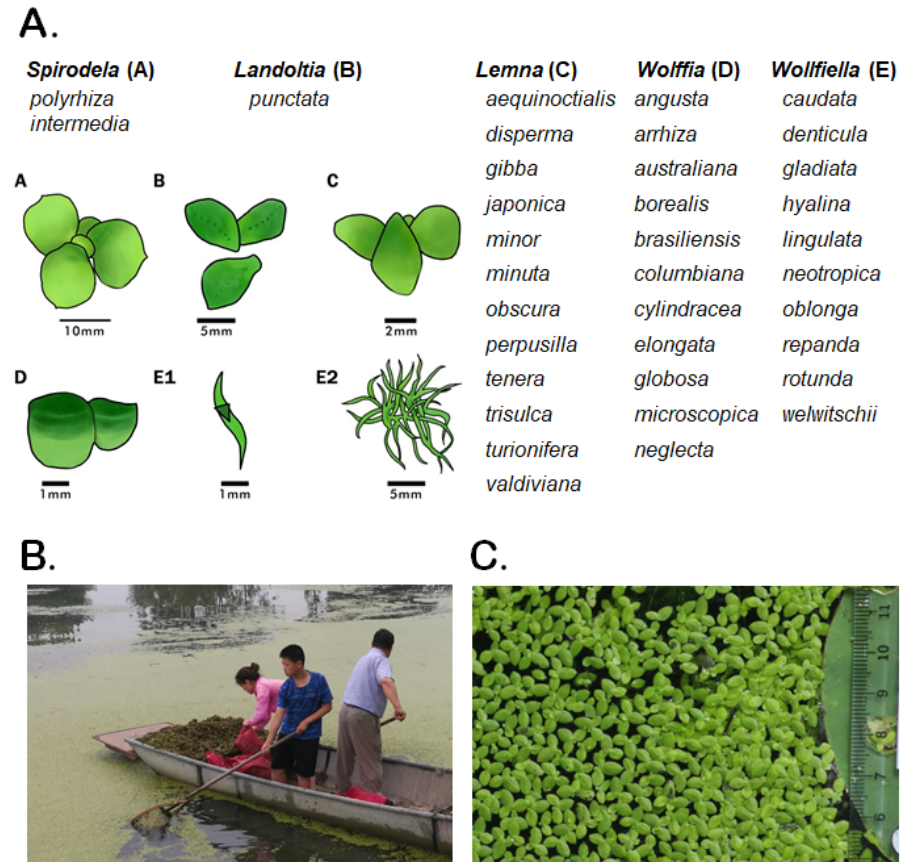
Figure 1. Duckweeds, the Lemnaceae plant family. ( A ) The Lemnaceae plant family contains 36 species grouped into five genera: Spirodela, Landoltia, Lemna, Wolffia, and Wolffiella . a, b, c, d, e1, e2 depict representative images of a species in the corresponding genera. The duckweed images are adapted from a drawing of Dr. K. Sowjanya Sree, Central University of Kerala, Periye, India [27]; ( B ) harvesting of duckweed covering a fishpond near Huai’an city, China; ( C ) Lemna aequinoctialis growing in the lake on the campus Huaiyin Normal University. Bar = 1 cm.